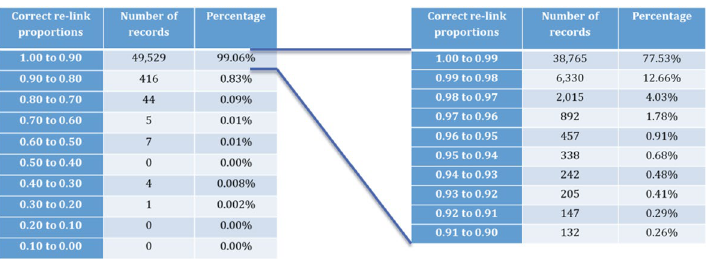
Table 4 Correct re-link proportion result on full